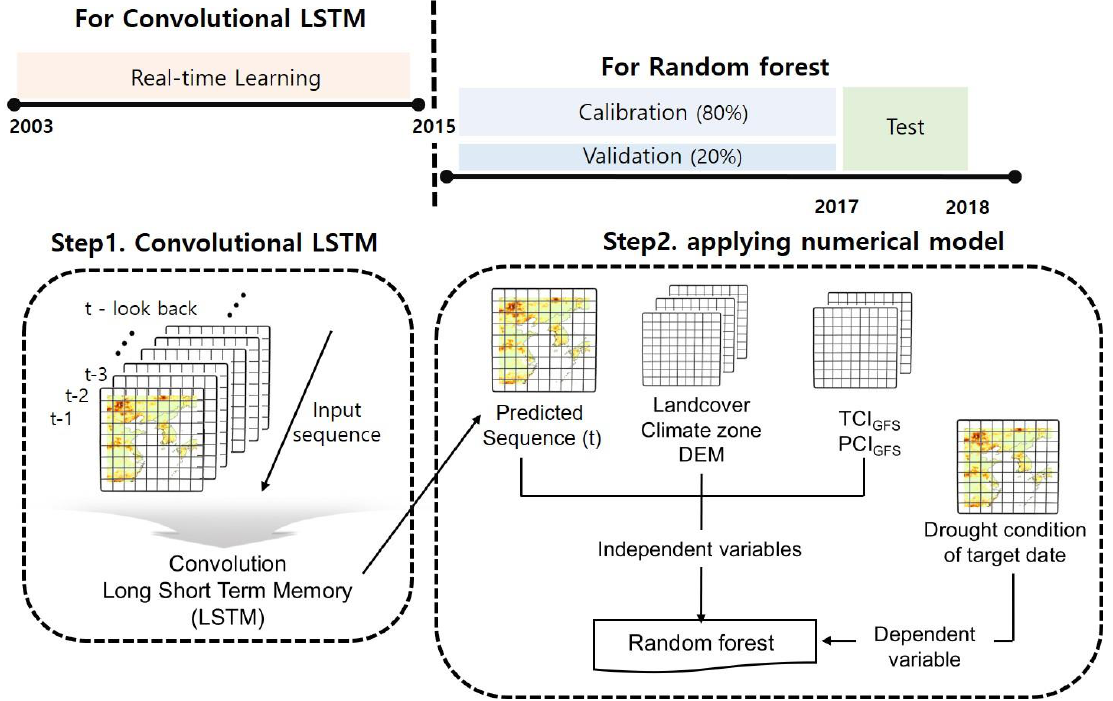
Figure 2. The process flow diagram of this study. Step1 used convolutional long short term memory (ConvLSTM) from 2003 to 2018 by real-time learning. Step 2 used random forest (RF) from 2015 to 2017). The test of the final drought-forecasting model was conducted for 2018.